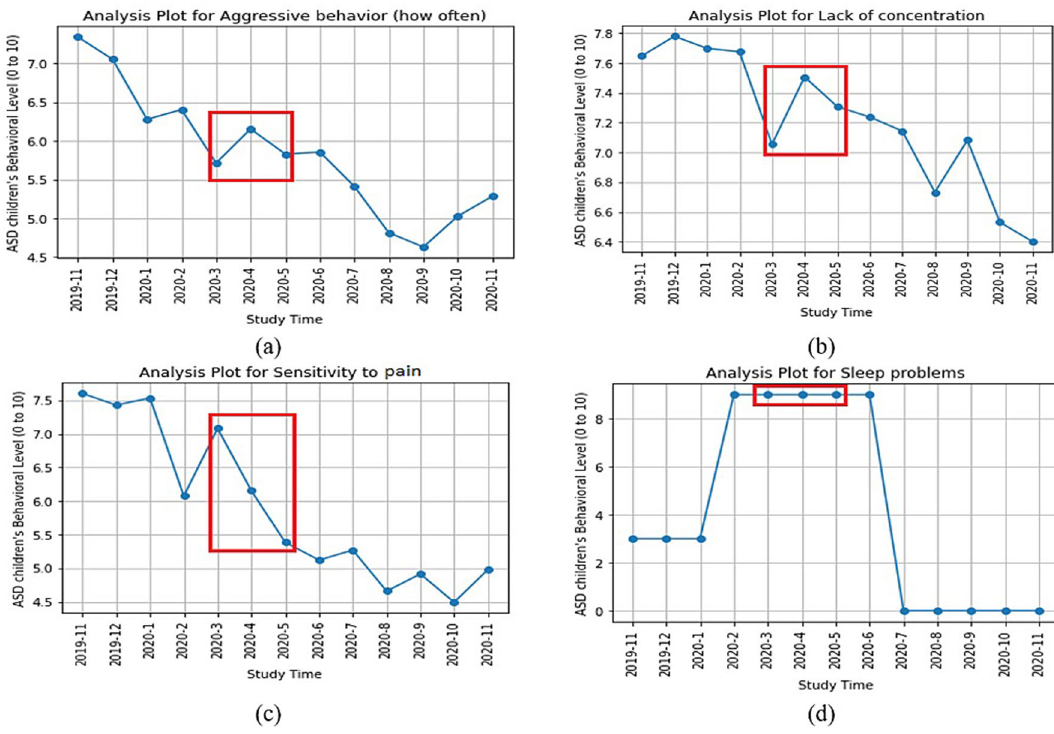
Figure 2. Graphical representation of the “negative impact” due to lockdown on children’s with ASD behavioral parameter: ( a ) aggressive behavioral (how often), ( b ) lack of concentration, ( c ) sensitivity to pain, and ( d ) sleep